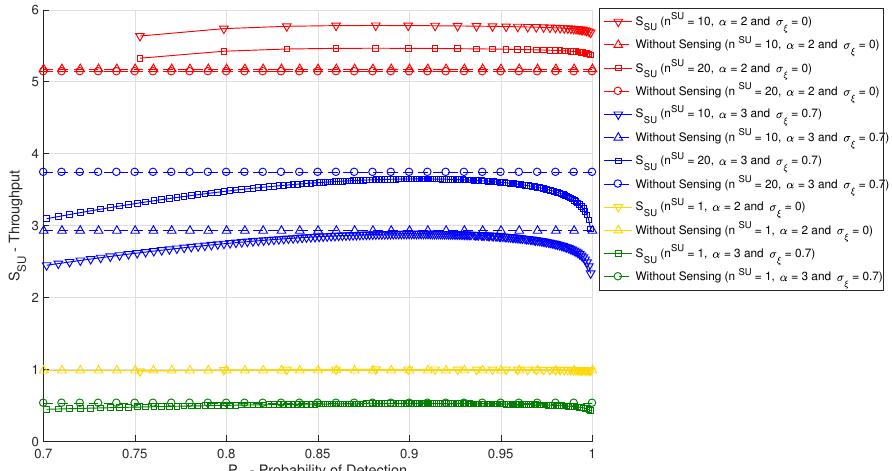
Figure 4. Conditional throughput ( S SU ) achieved by SU versus P D , for n SU = { 1,10,20 } nodes, α = { 2,3 } and σ ξ = { 0,0.7 }